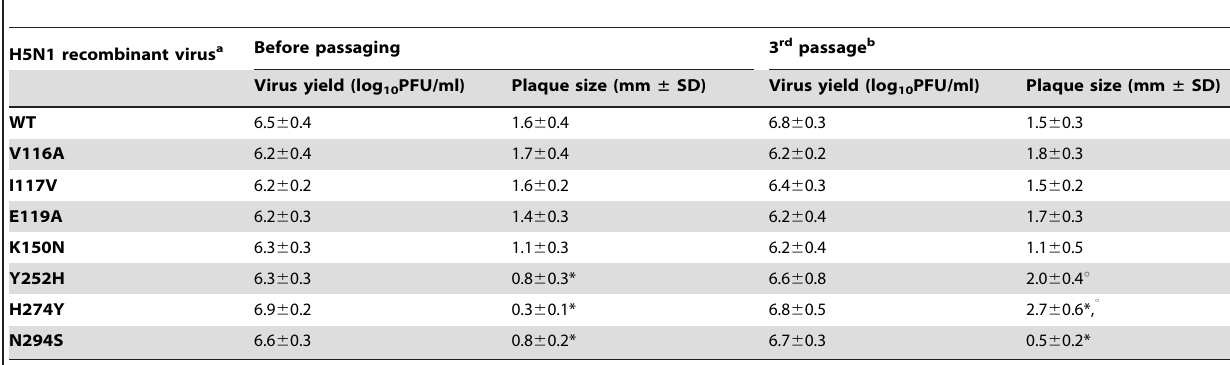
Table 1. Growth of Recombinant H5N1 Influenza Viruses Before and After Passaging in MDCK Cells.